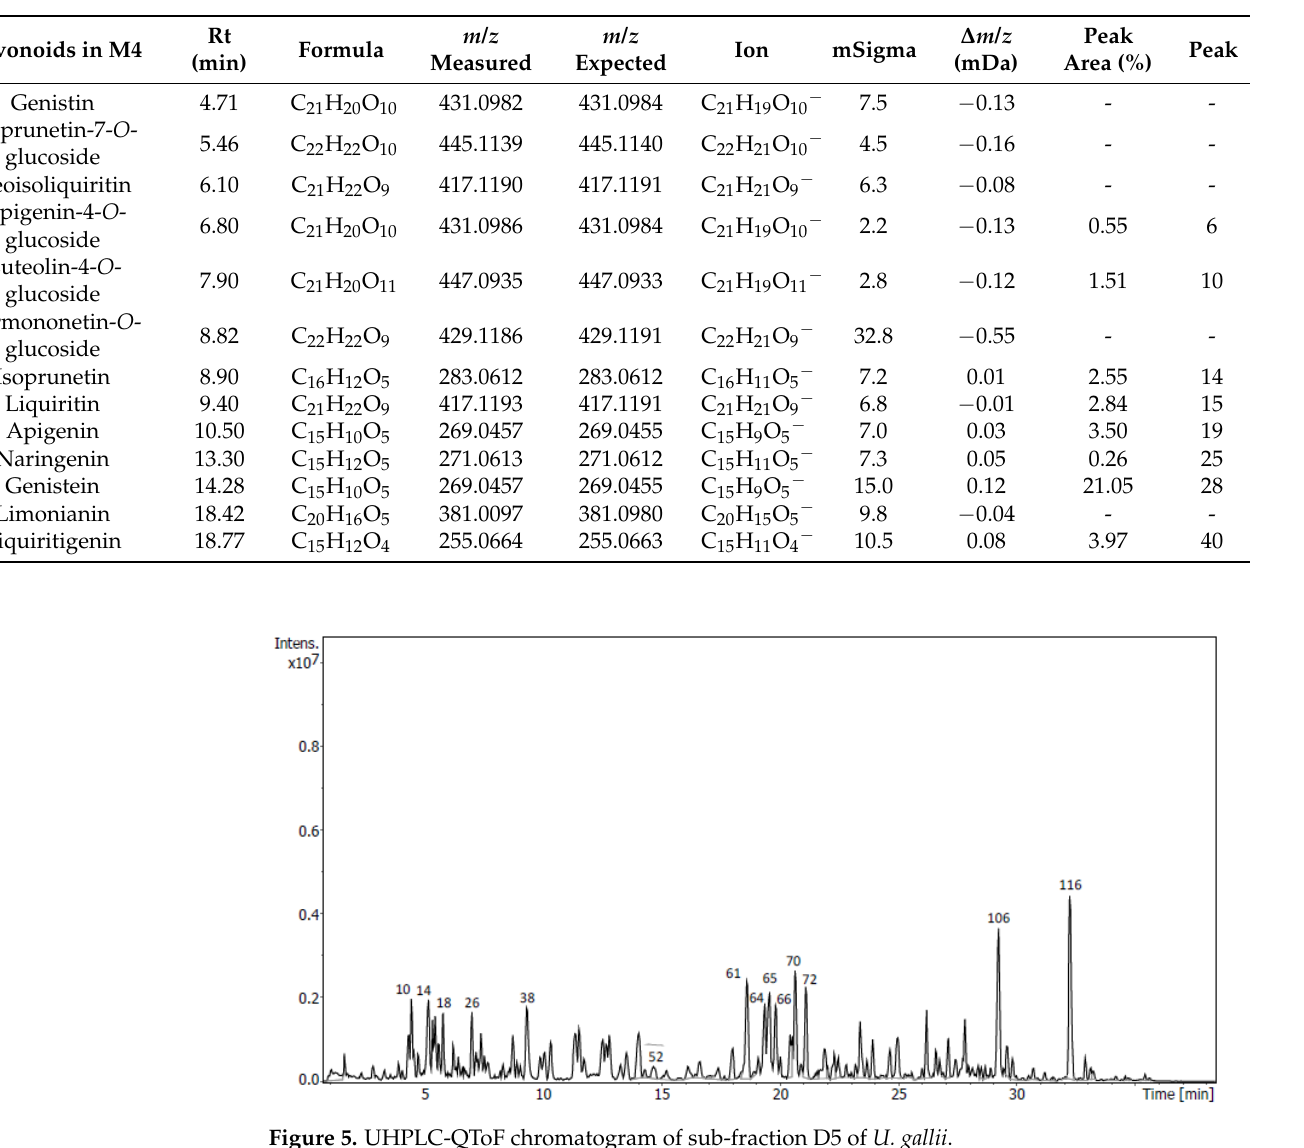
Table 5. Flavonoids identified in targeted analysis via UHPLC-ESI-QToF of sub-fraction M4 of U. gallii (Rt = retention time, m / z = mass/charge ratio of the compound, mSigma = deviation in the isotopic pattern, ∆ m / z = deviation in the mass ratio/charge measured in relation to the expected value).